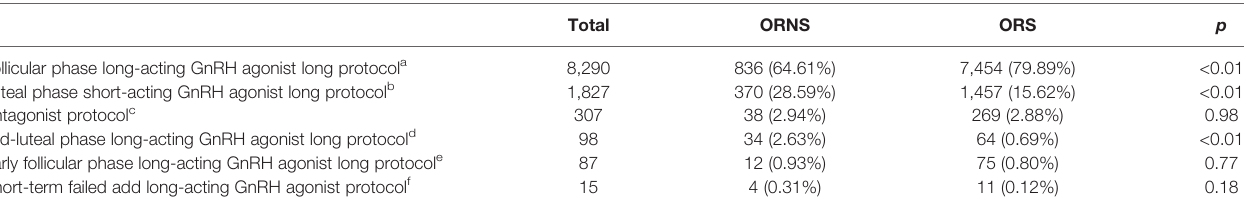
TABLE 2 | Stimulation protocol comparisons between the ORNS and ORS.